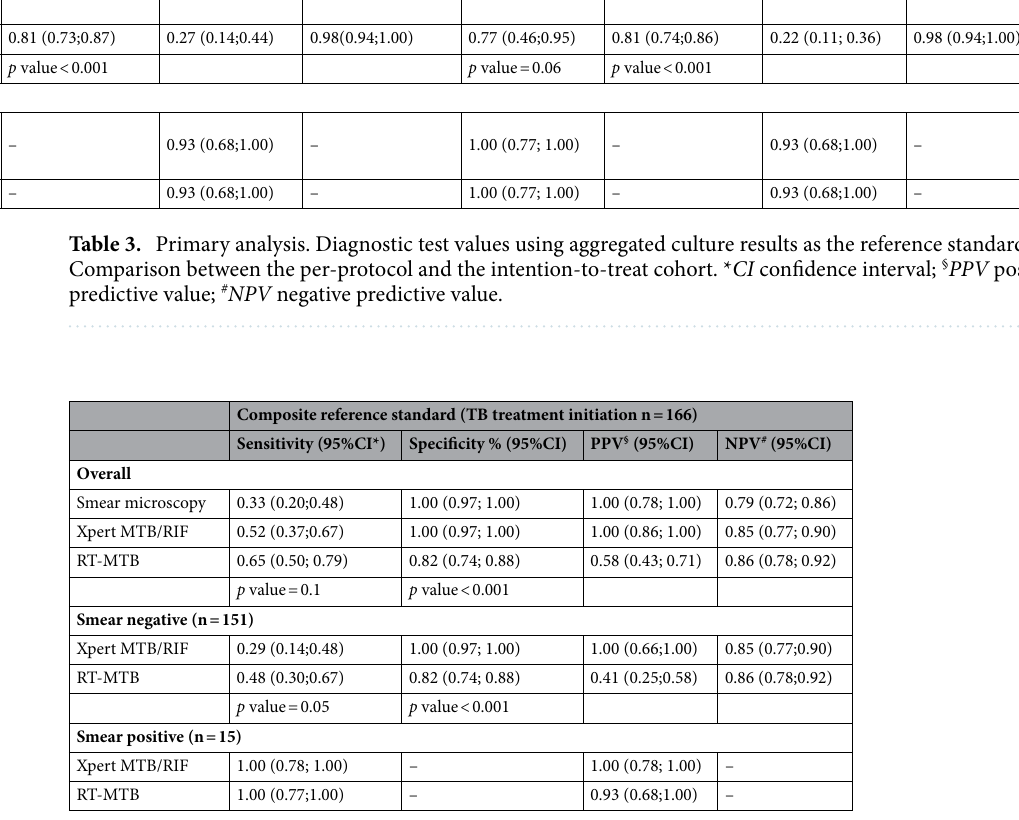
Table 4. Per-protocol secondary analysis. Diagnostic test values using the composite reference standard (Tuberculosis treatment and microbiological results) n = 166. * CI confidence interval; § PPV positive predictive value; # NPV negative predictive